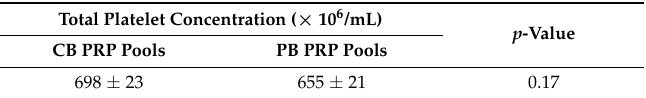
Table 1. Cord and peripheral PRP pools